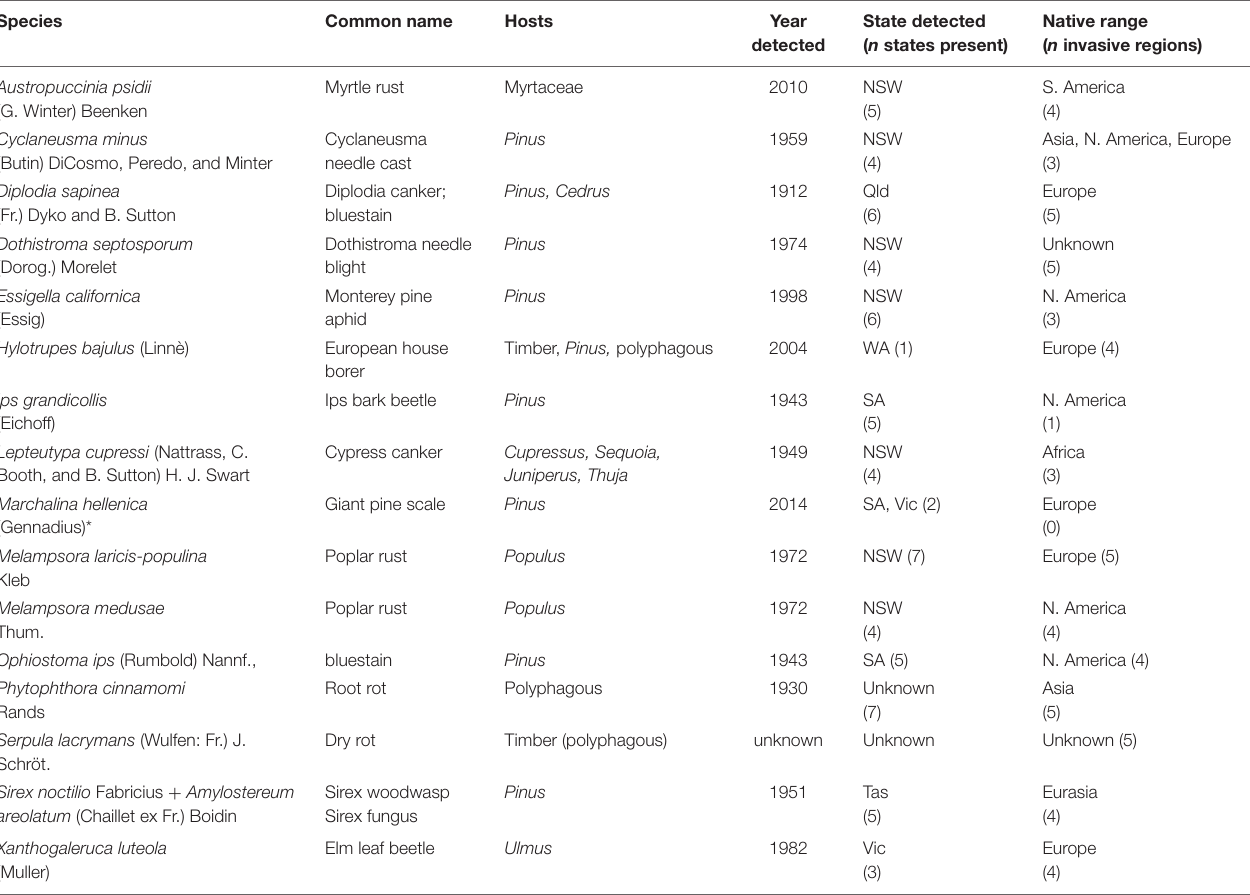
TABLE 2 | High-impact non-native forest pests established in Australia, main hosts affected, year, and state (Tas = Tasmania, Qld = Queensland, NSW = New South Wales, SA = South Australia, Vic = Victoria) of first detection, number of Australian states now present, native range and number of global regions the pest is non-native (in addition to